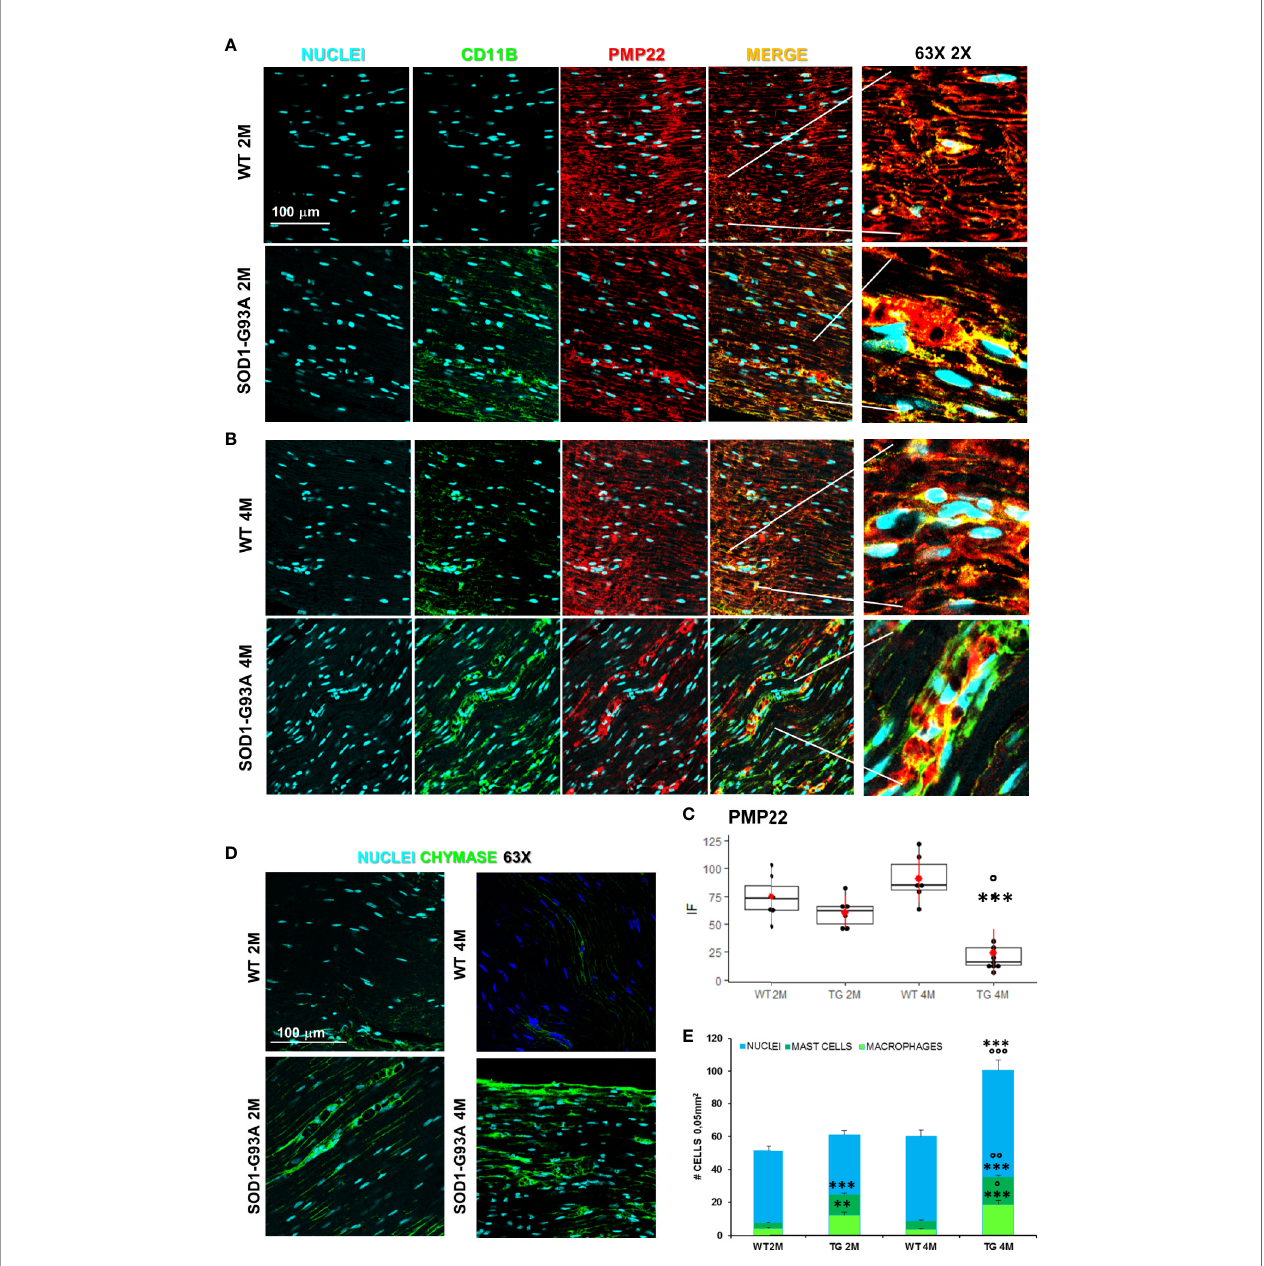
FIGURE 3 | Myelin degeneration and activation of immune-resident cells in SOD1-G93A+ sciatic nerves. (A) Representative examples of confocal images of macrophages (green) and PMP22 expression (red) in 2 months and (B) 4 months old mice (magni fi cation 63X and zoom 2X). (C) RGB evaluation of PMP22 expression in both 2 (2M) and 4 months (4M) old WT and SOD1-G93A (TG) mice. Mean is the red point and +/- SD added as pointrange. (N = 3/5 animals group x at least 2 slices/mouse; °p <0.05 vs 2M and ***p <0.0001 vs WT). (D) Sample images (magni fi cation 63X) representing mast cells (green) in sciatic nerves and (E) Cells count. Total cells (nuclei, cyan – N = 5 – 7 animals/group x at least 2 slices/mouse), number of macrophages (light green) and mast cells (dark green) (N = 3 – 5 animals group x at least 2 slices/mouse). °p < 0.05, °°p < 0,001, °°°p < 0,0001 vs 2M and **p < 0,001, ***p < 0.0001 vs disorder. As shown in Figure 5A immuno fl uorescent IgGs are months and strongly enhanced in 4 months old mice (H 5 = 21.8, p = 0.00056; Dunn-Test post-hoc TG 1.5M vs WT 2M p = 0.017; TG 2M vs WT 2M p = 0.014; TG 4M vs WT 4M p = 0.013). Since NF/kB pathway controls innate and adaptive immune response and the protein A20 is a master regulator of NF/kB (46),